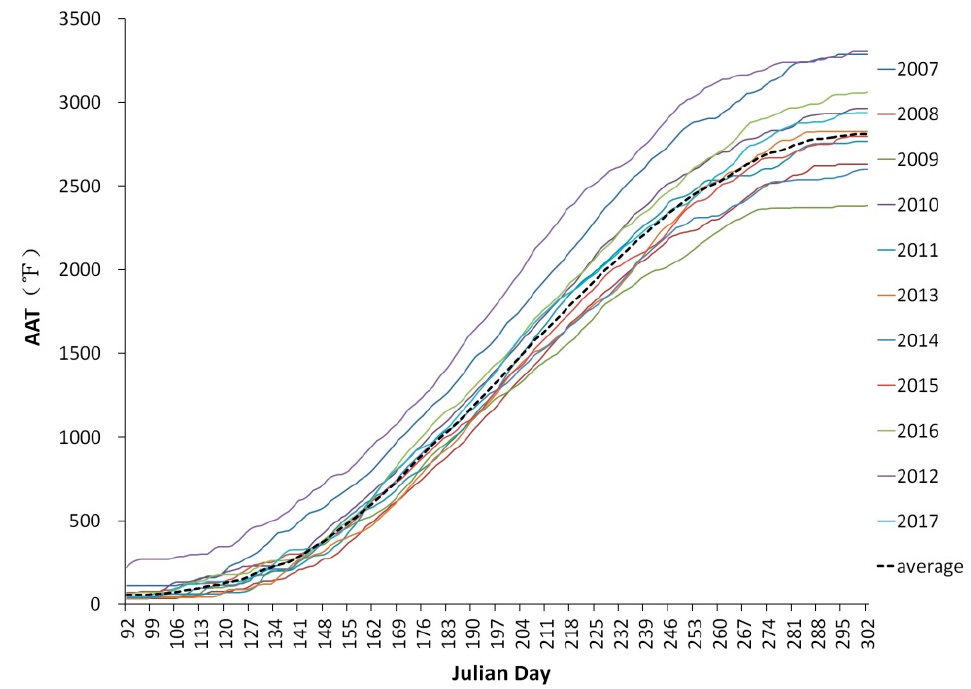
Figure 6. The AAT curves cover the corn growing season in Carroll County from year 2007 to 2017 and the AAT baseline (dashed line). The abnormal year 2012 is excluded in the baseline calculation.